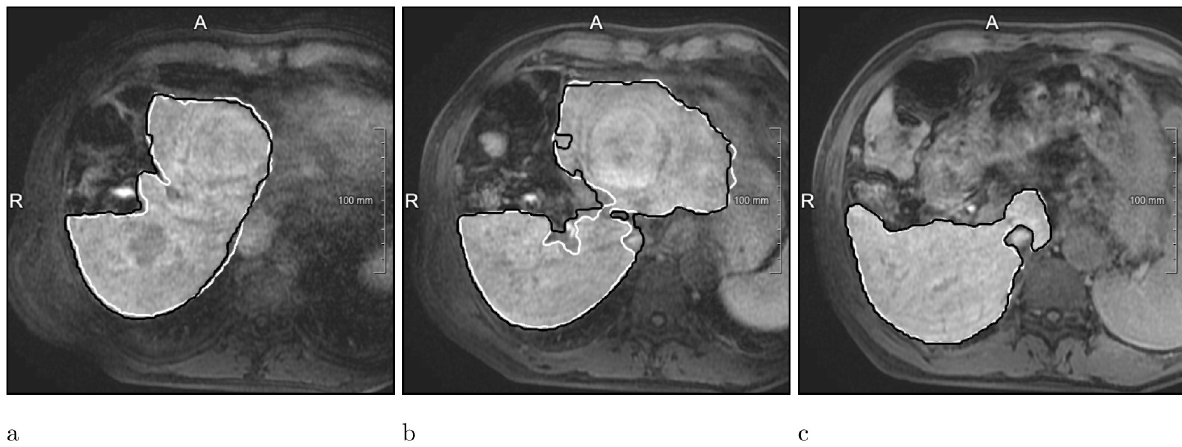
Fig 9. Resected liver case, where the Liver-Net method (black) produced segmentation consistent with the reference (white): 3% RVE and 0.95 DICE.